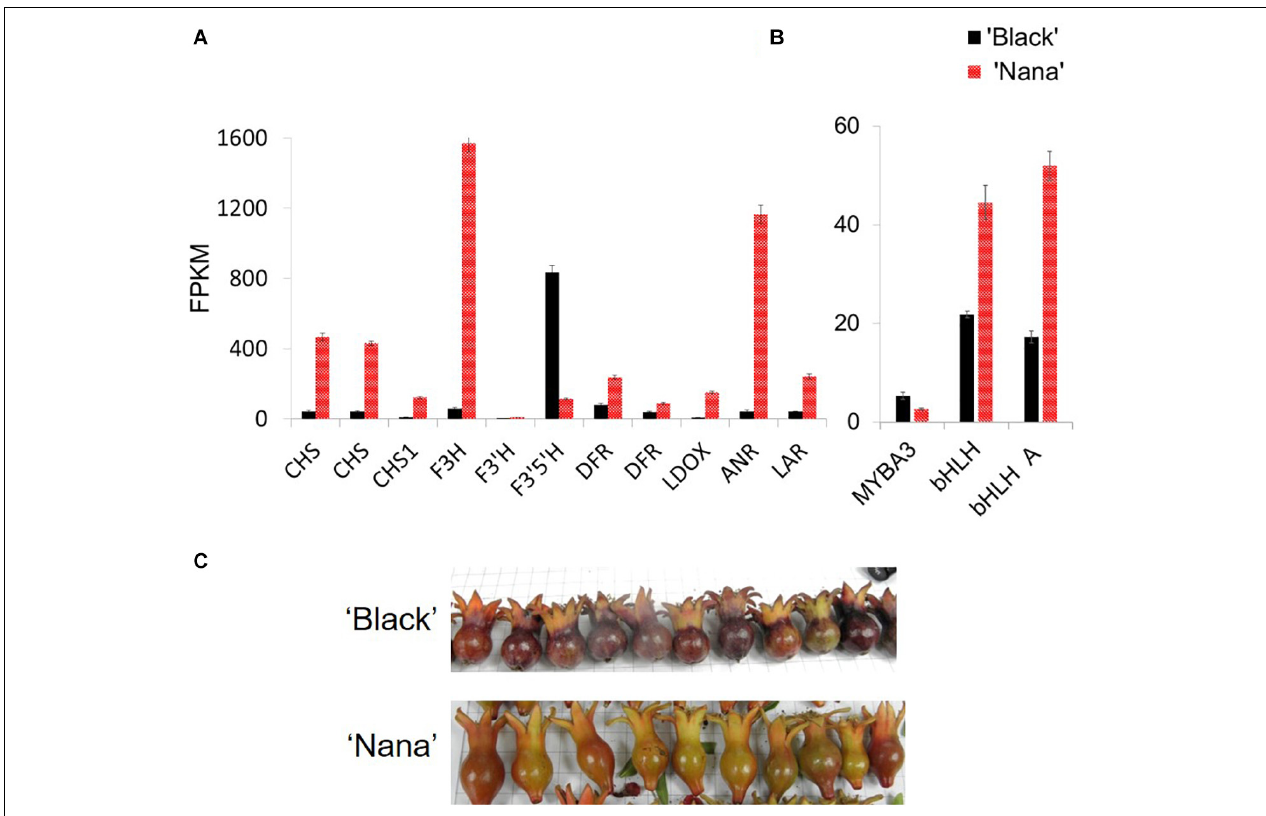
FIGURE 7 | Differential expression of genes from the anthocyanin pathway in ‘Black’ and ‘Nana’ young fruitlets. Peels were collected from fruits of ‘Black’ (black columns) and ‘Nana’ (red columns). Fruitlets were collected a few days after pollination. Expression analysis is explained in detail in the Materials and Methods section. (A) Genes corresponding to anthocyanin pathway. Gene names according to Qin et al. (2017): left to right: CDL15_Pgr005566 (CHS), CDL15_Pgr025723 (CHS), DL15_Pgr026373 (CHS1), CDL15_Pgr020918 (F3H), CDL15_Pgr008828 (F3’H), CDL15_Pgr026644 (F3’5’H), CDL15_Pgr021400 (DFR), CDL15_Pgr021400 (DFR), CDL15_Pgr017842 (LDOX), CDL15_Pgr017032 (ANR), CDL15_Pgr024128 (LAR). (B) Regulatory elements. From left to right- MYBA3 (JF747151), bHLH (CDL15_Pgr025), bHLH (JF747152). (C) Fruitlets analyzed showing the observed peel color at this stage. FPKM, fragments per kilo base per million mapped